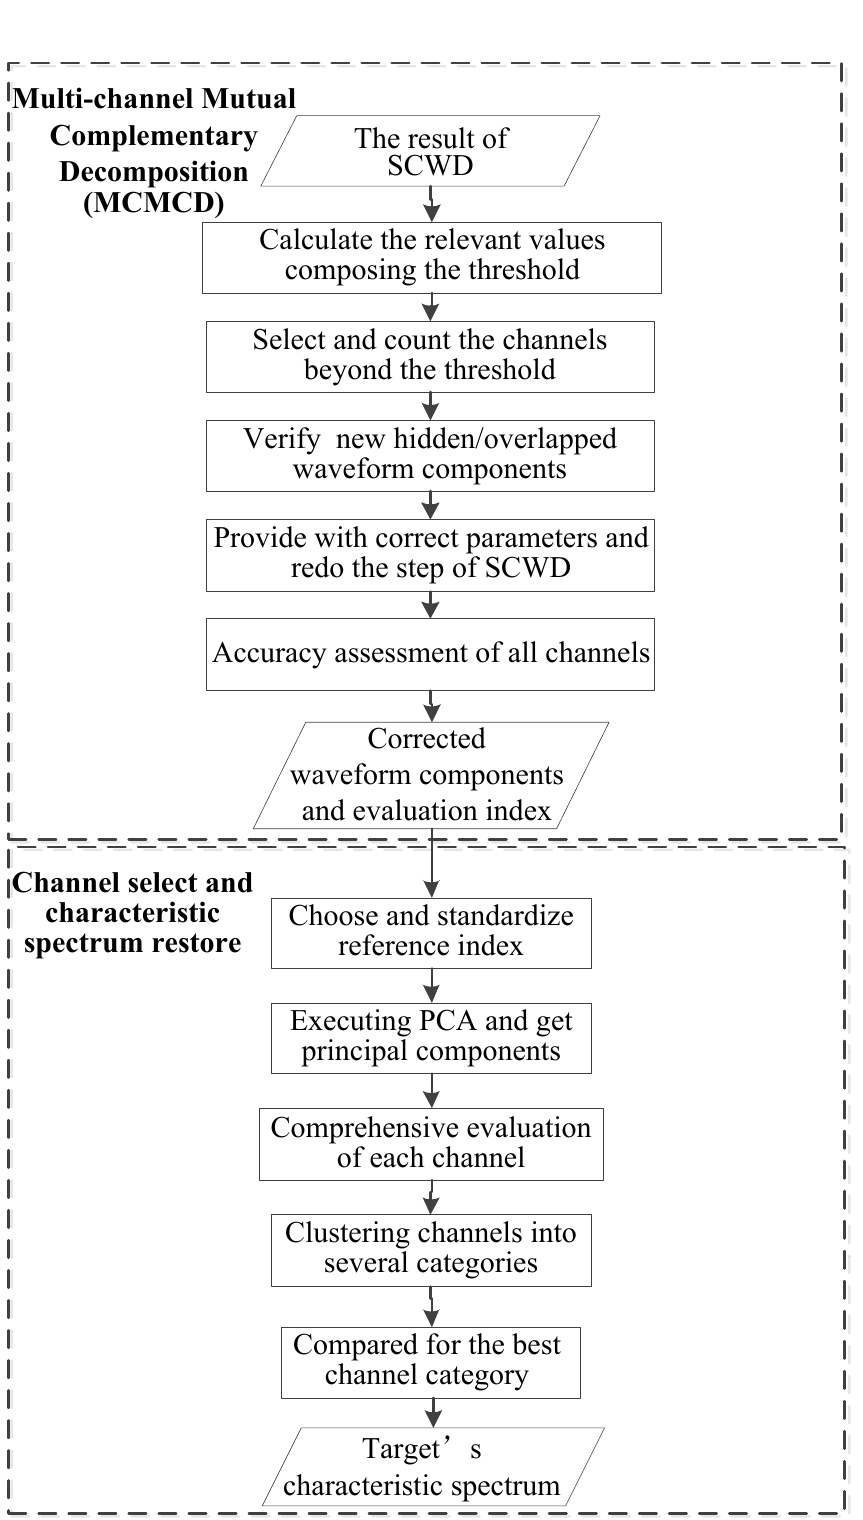
Figure 4. Flowchart of 101-channel HSL data processing method for revealing components and extracting spectra.